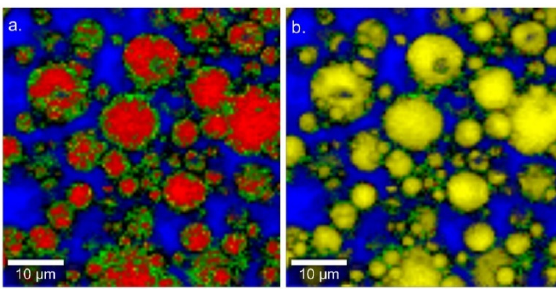
Figure 1. Confocal Raman microscopic color-coded images of aqueous pre-dispersion ( a ) Red: TE, Green: PL90H, Blue: Water, ( b ) shows TE removed in the image to facilitate the better identification of the yellow sunflower oil (SO).